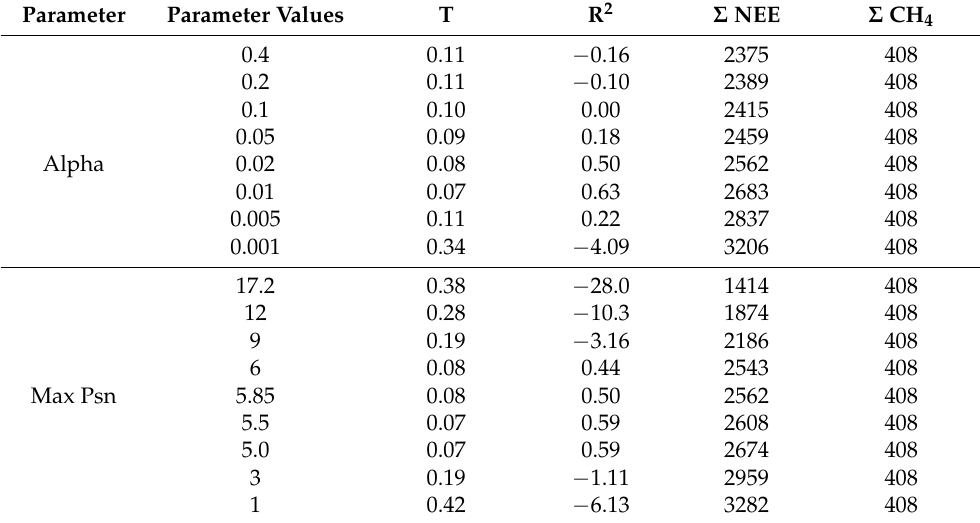
Table 2. The modelled annual variants of the Wetland-DNDC sensitivity analysis to the moss layer input